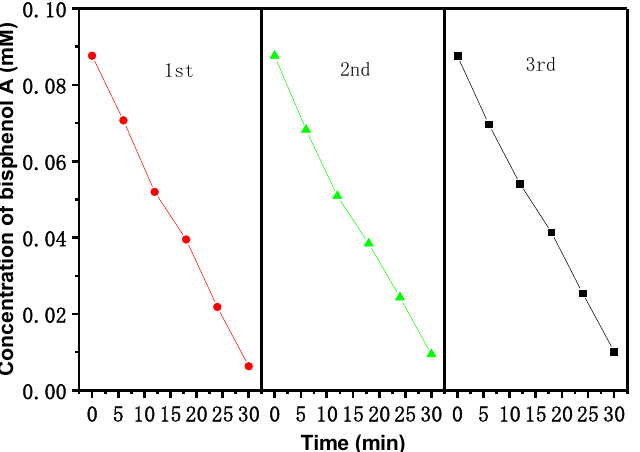
Figure 13. Concentration variation curves of bisphenol A with Ag 3 PO 4 and potassium persulfate as catalysts under visible light irradiation for three cycles of degradation tests.